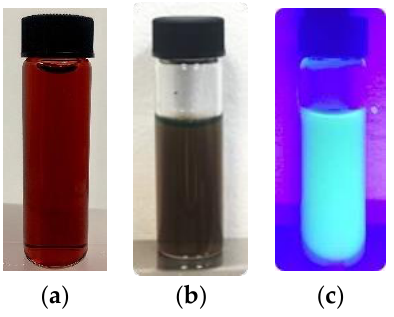
Figure 9. ( a ) Red ruby solution of AuNPs, ( b ) AuNPs-FI in visible light, and ( c ) AuNPs-FI exposed under ultraviolet light λ = 395 nm.